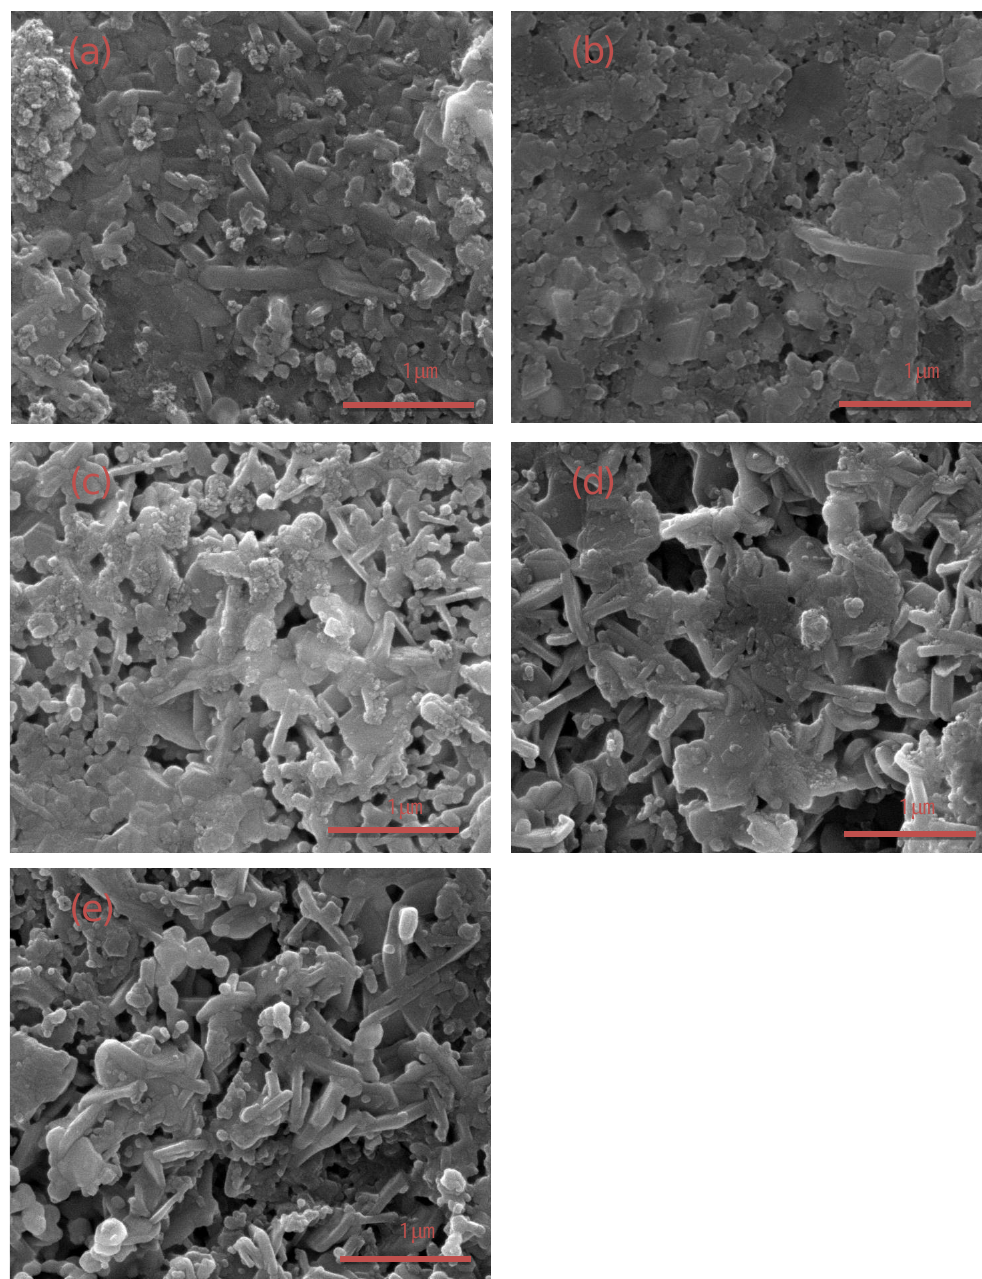
Figure 2. SEM images of Mg-based lanthanum hexaaluminate with different Co doping amounts. ( a ) x = 0.5, ( b ) x = 1.0, ( c ) x = 1.5, ( d ) x = 2.0, ( e ) x = 2.5.